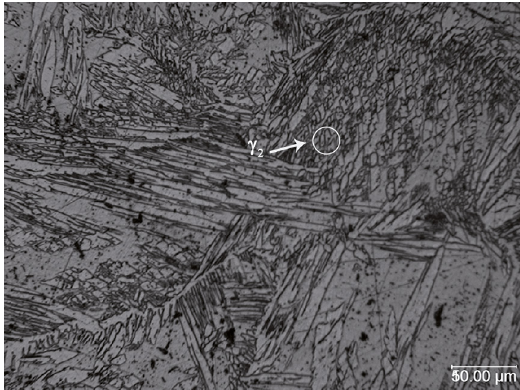
Figure 1: OM micrograph of secondary austenite in the FZ (FCAW root of weld joint with 2209 as filler metal)